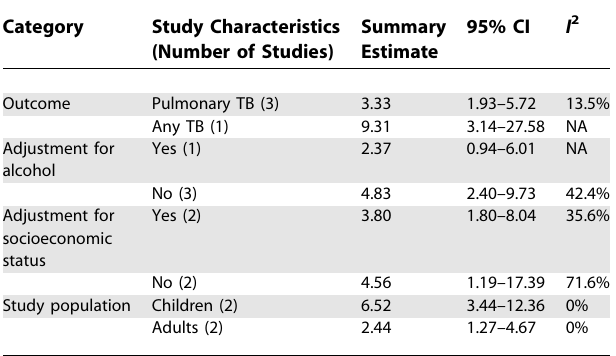
Table 5. Quality Assessment and Subgroup Analysis: Passive Smoking and TB